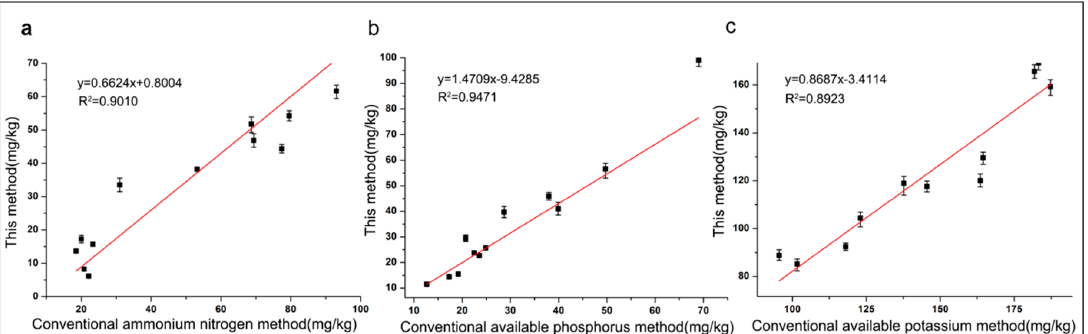
Figure 5. Comparison analysis of measurement results obtained from both conventional lab-based method and this multichannel optoelectronic measurement system: ( a ) the relationship of measured nitrogen established by the Nash colorimetric method, ( b ) the relationship of measured available phosphorus established by the Olsen method, ( c ) the relationship of measured potassium established by the Flame photometer method.